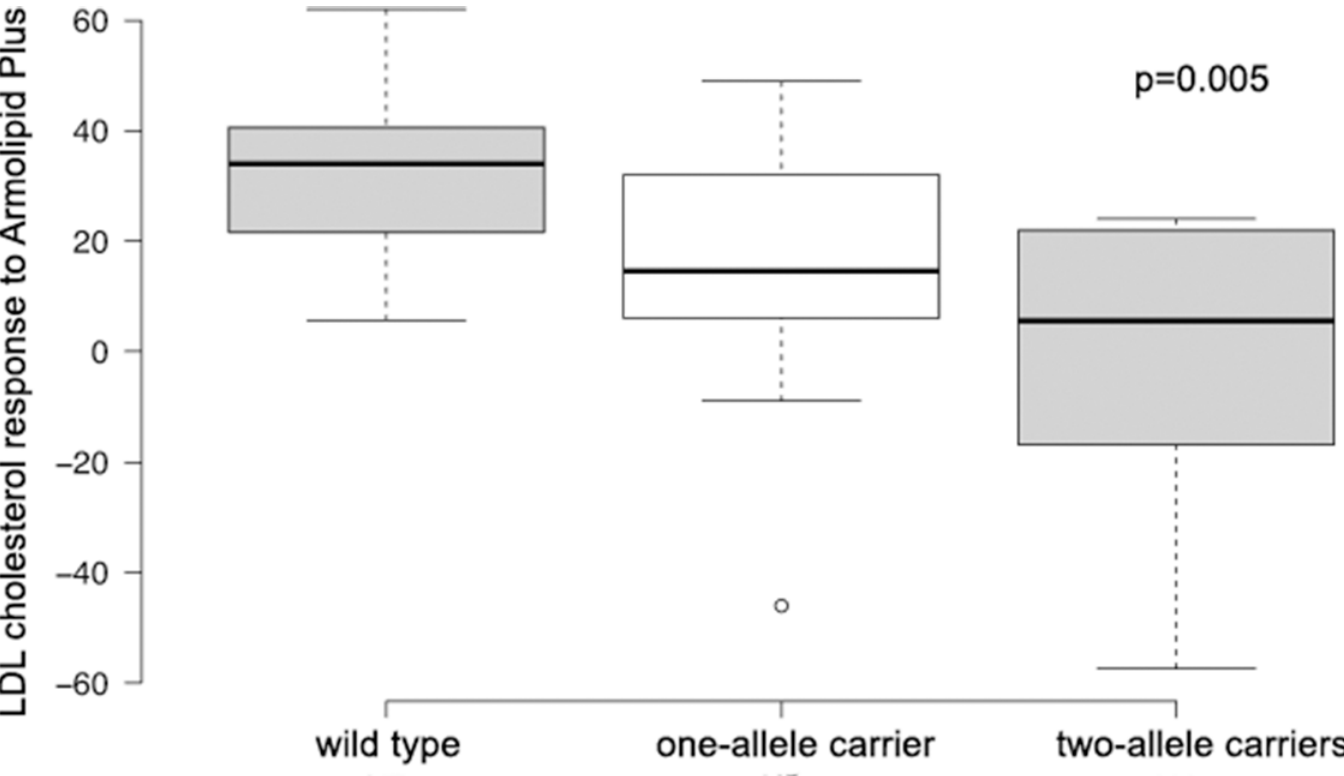
Fig 1. Study subjects classified according to status as carriers of c. − 3383C > G PCSK9 and c. * 52G > A LDLR variants and response of LDL cholesterol levels to Armolipid Plus.